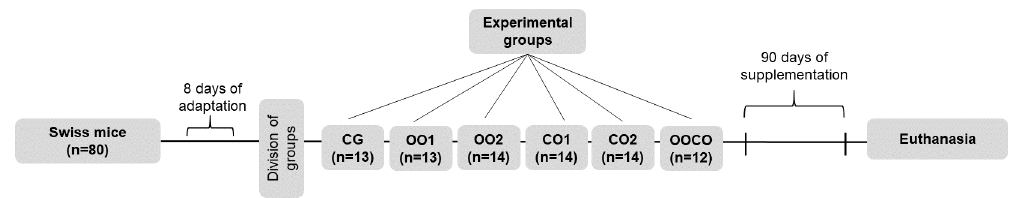
Figure 6. Intervention protocol of the supplementation with Caryocar brasiliense oil. CG indicates control group, supplemented with soybean oil (1000 mg/kg); OO1 and OO2 groups receiving olive oil (1000 mg/kg and 2000 mg/kg, respectively); CO1 and CO2 groups supplemented with C. brasiliense oil (1000 mg/kg and 2000 mg/kg, respectively); and OO + CO group receiving olive oil (1000 mg/kg) with C. brasiliense oil (1000 mg/kg).